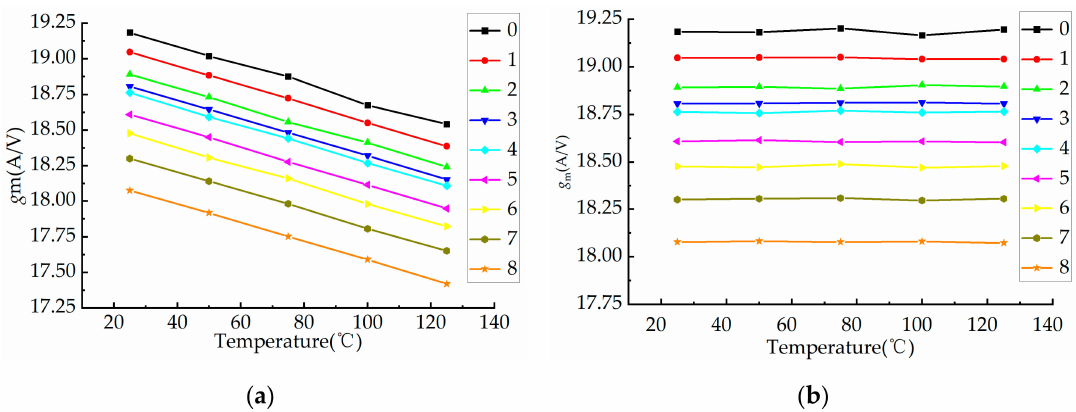
Figure 10. Transconductance of Chip 1 bonding wire fault module: ( a ) before temperature calibration and ( b ) after temperature calibration.